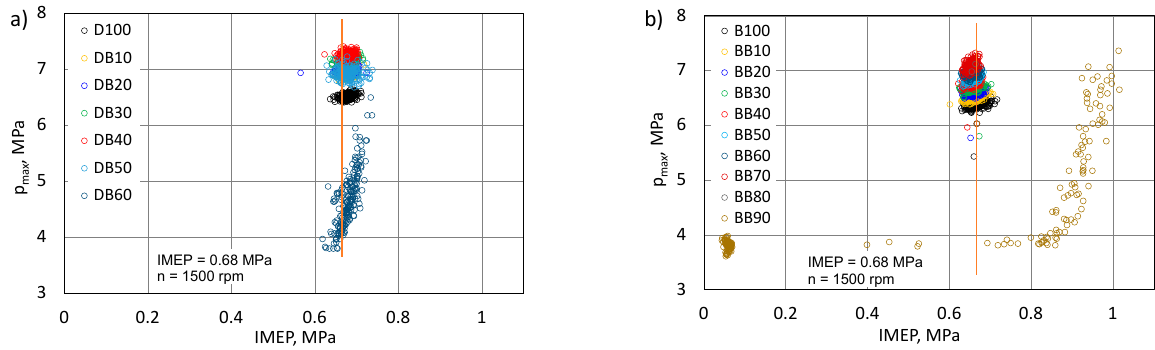
Figure 15. Correlation of maximum pressure and IMEP for DB ( a ) and BB ( b ). The IMEP value is closely related to the pressure in the engine cylinder. In the opti ‐ mal cycle of a piston engine, the maximum pressure is several degrees after the TDC [45].